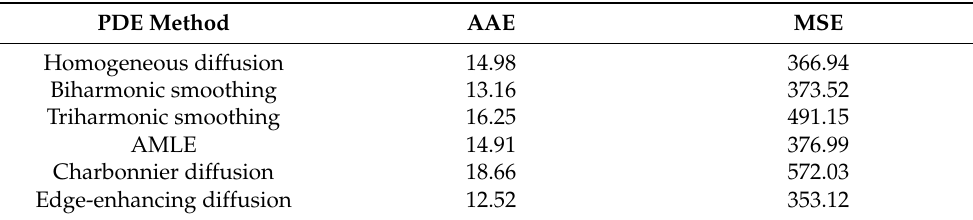
Table 1. Average absolute error (AAE) and mean square error (MSE) for the sparse data interpolation of the image horse .